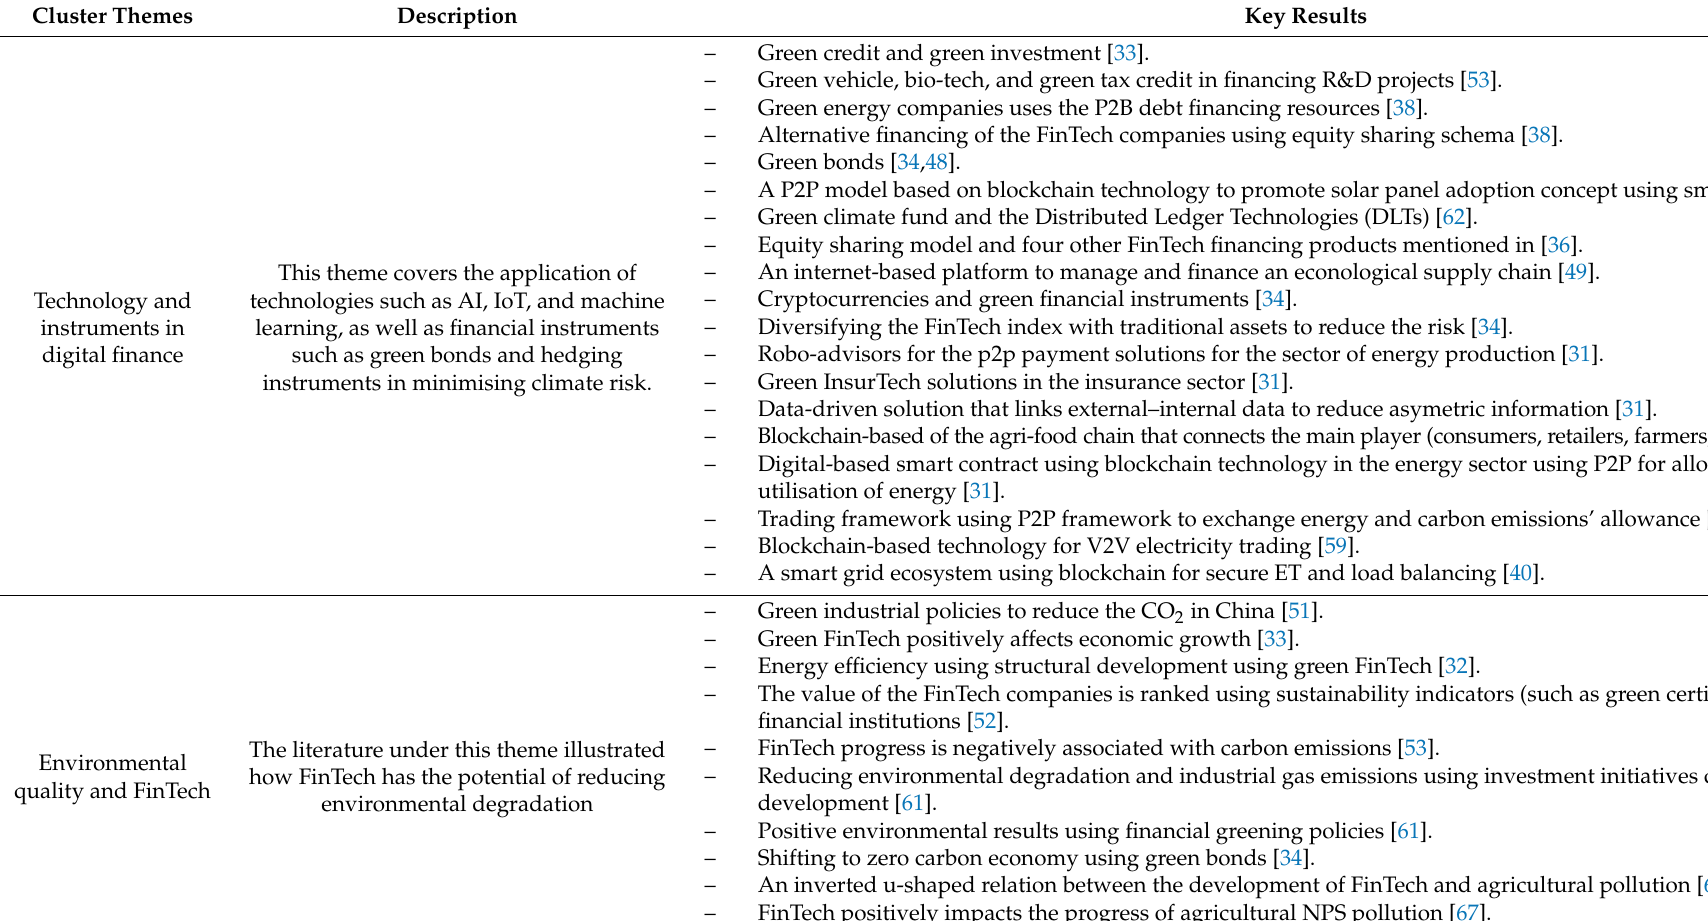
Table A2. Clusters of systematic-cum-bibliometric